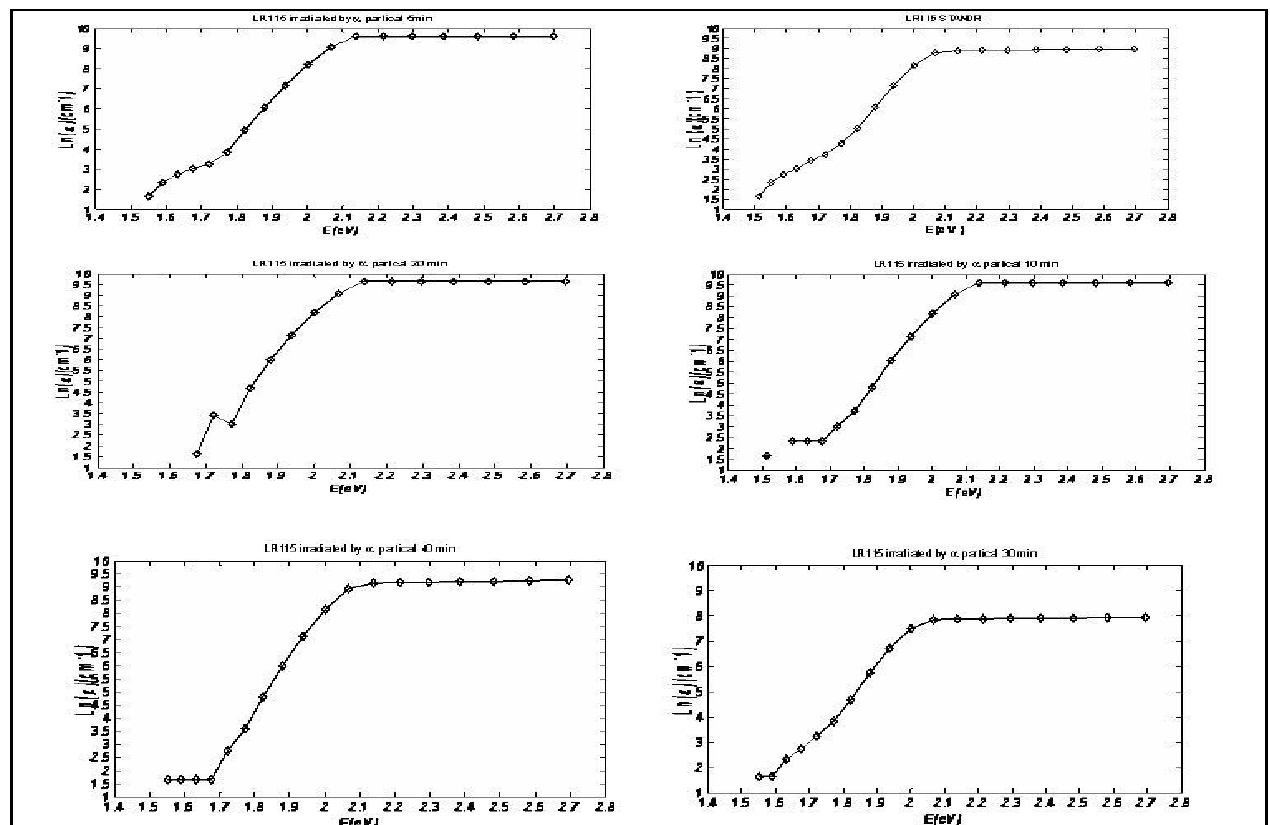
Fig. 2:The dependence of natural logarithm of α on photon energy for pristine and alpha irradiated LR-115